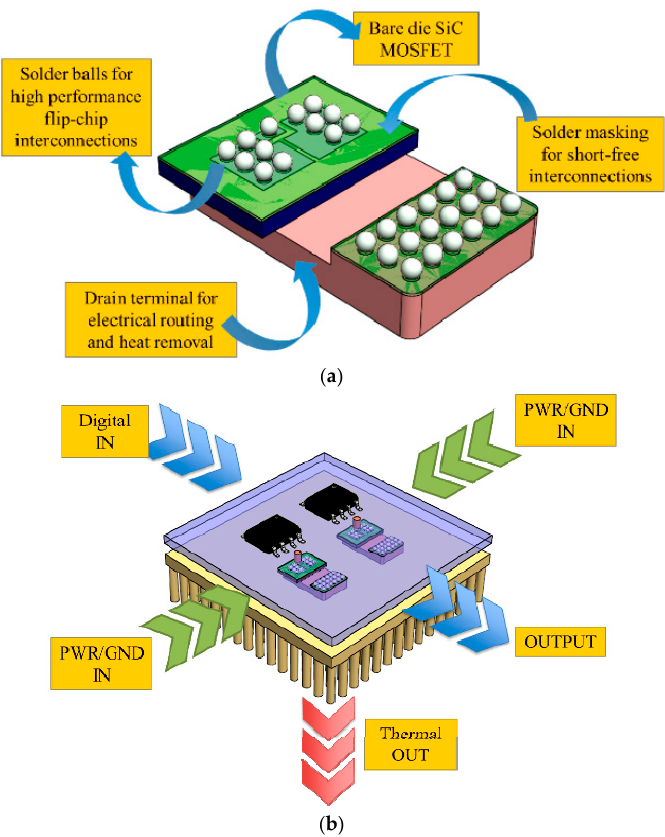
Figure 17. ( a ) A schematic showing the proposed chip scale MOSFET; and ( b ) a schematic showing the module implementation of the chip-scale MOSFET